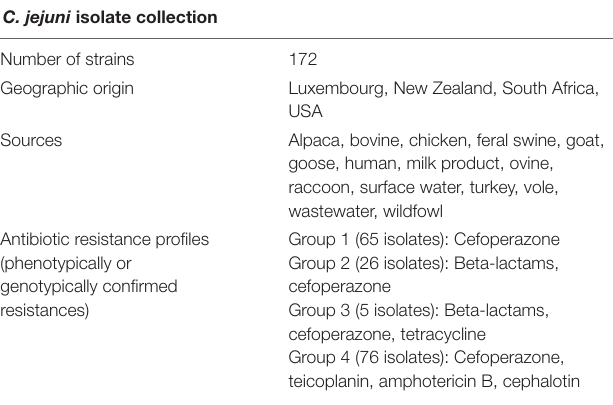
TABLE 1 | Characteristics of the Campylobacter jejuni isolates used in this